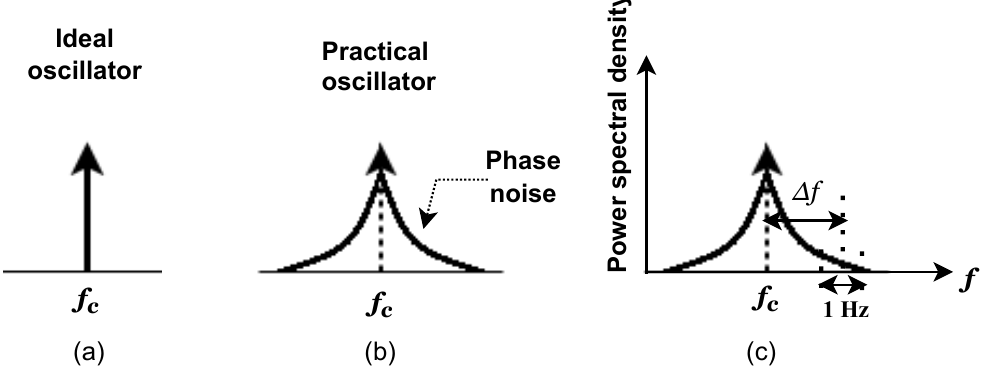
Figure 13. Phase noise of the local oscillator. ( a ) Ideal oscillator, ( b ) practical oscillator, and ( c ) phase noise power level in dBc/Hz with ∆ f